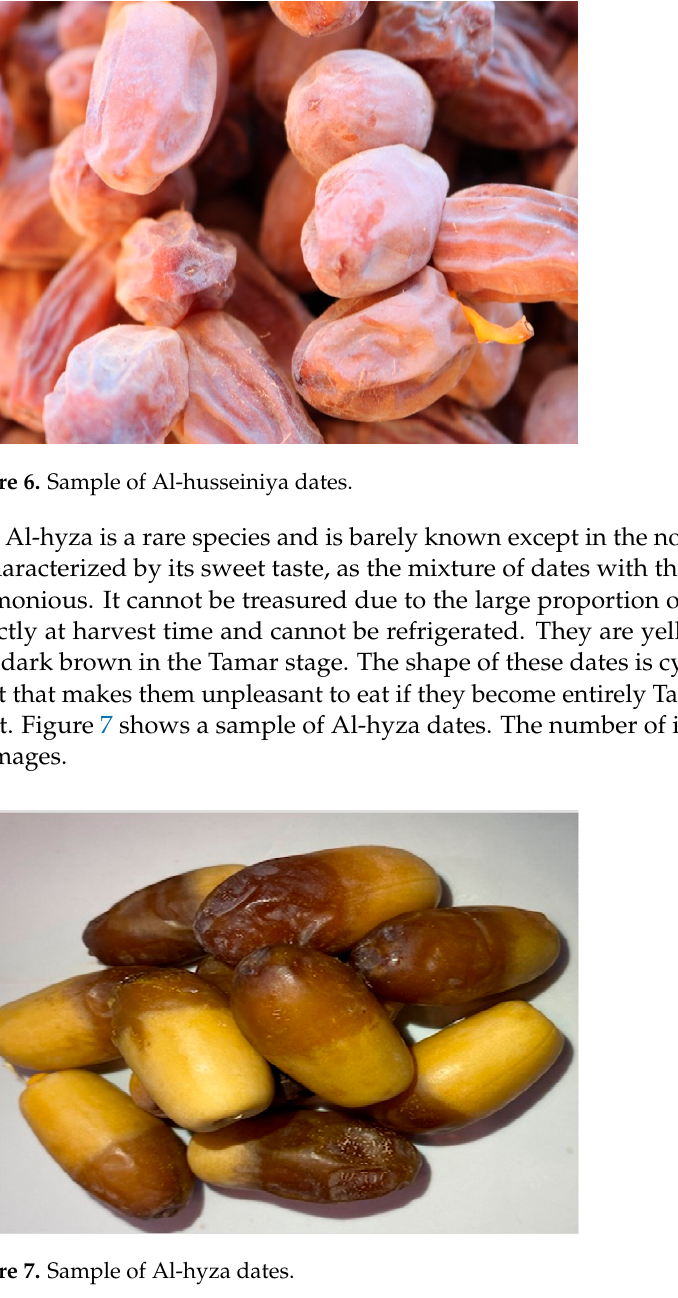
Figure 5. Sample of Al-helwa Macnooz dates.